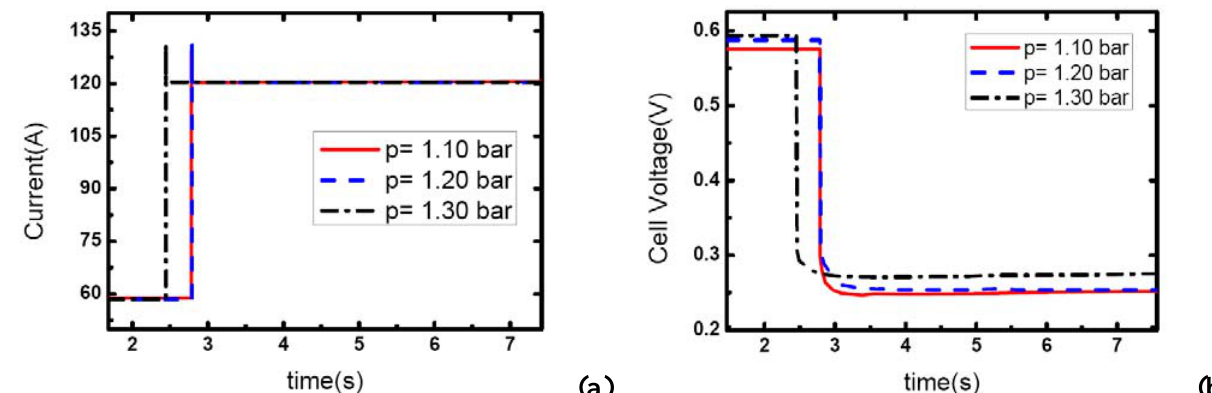
Figure 9. (a) Current change at three different operating pressures while λ to 2.43, (b) corresponding dynamic responses of